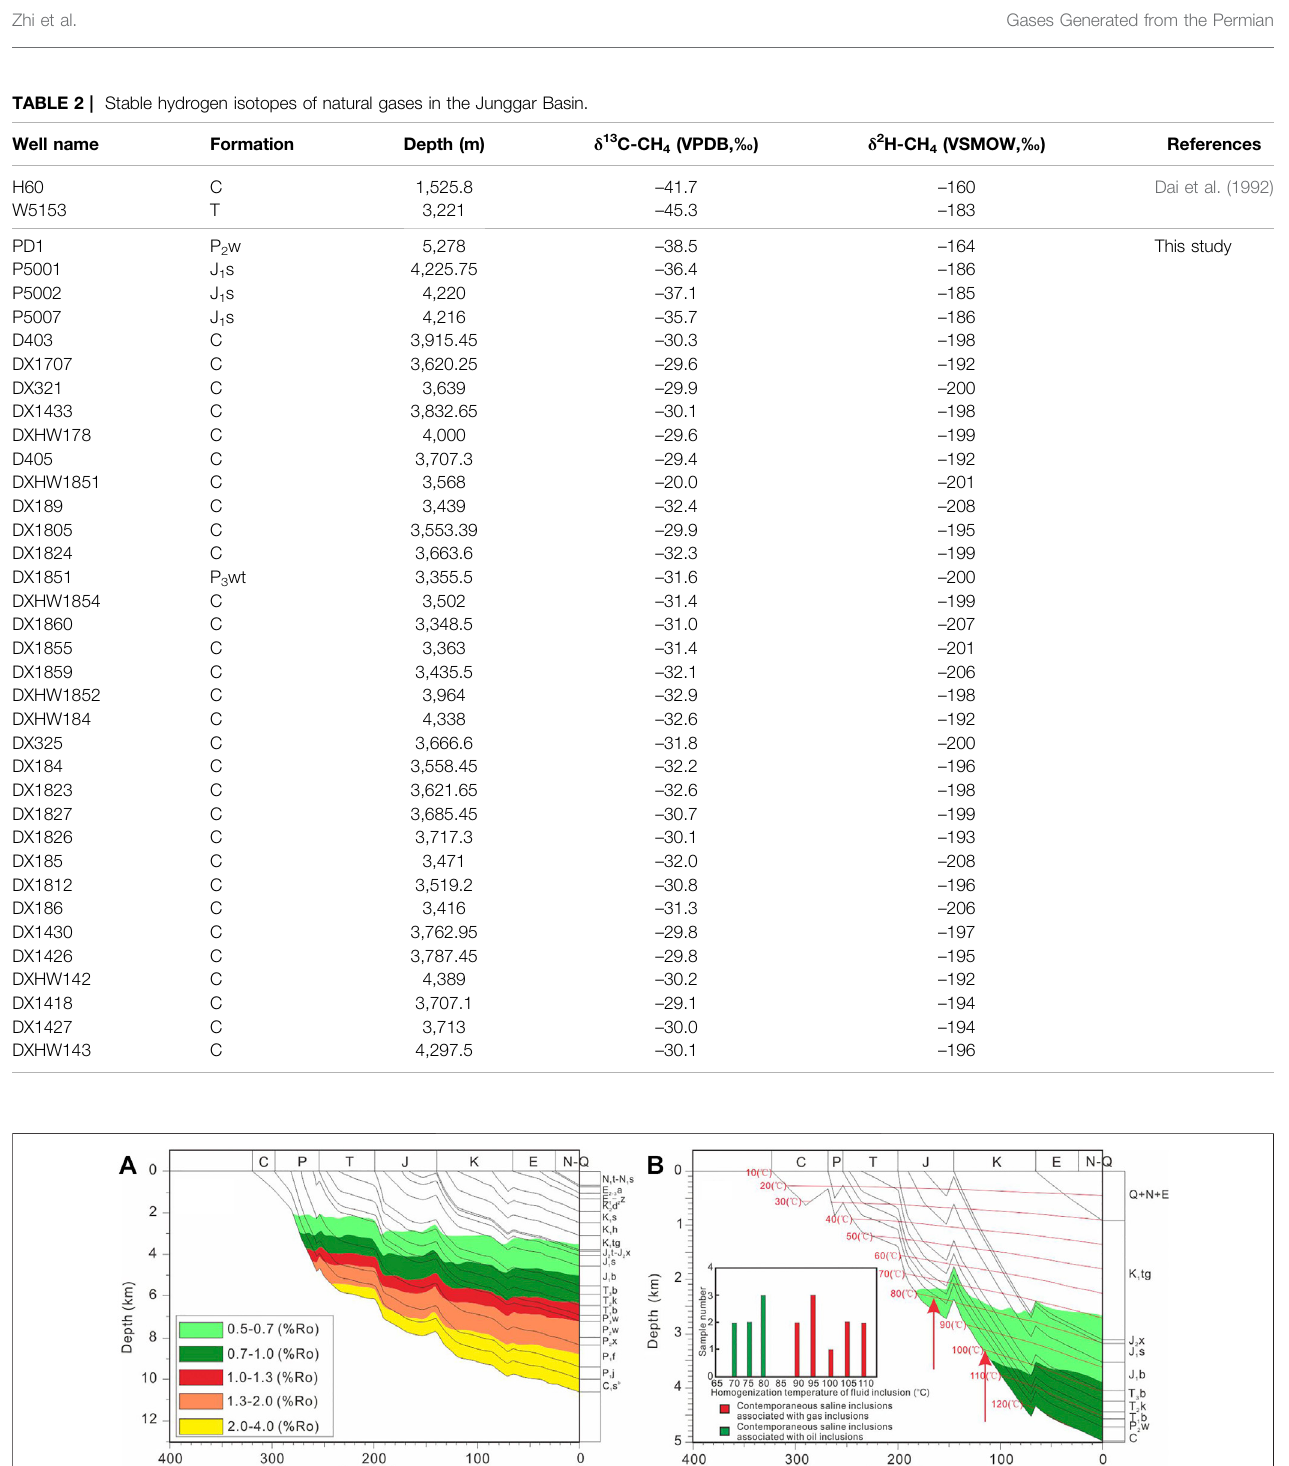
Frontiers in Earth Science |